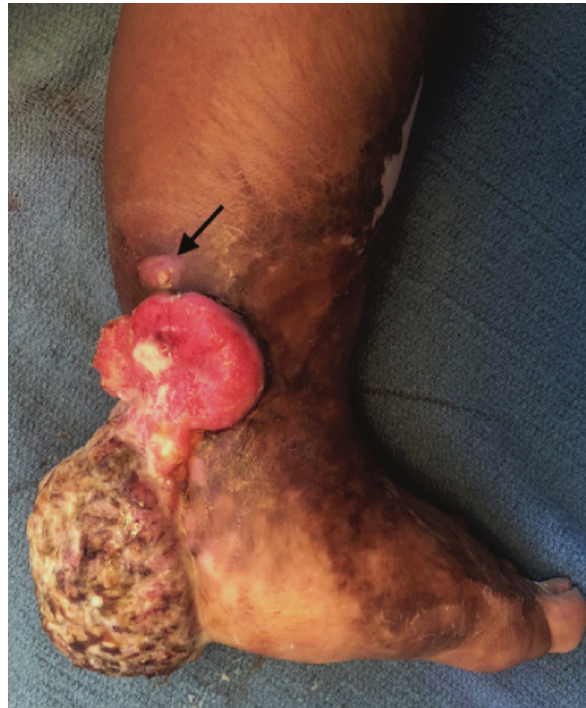
Lateral view of the foot. Involving the entire heel and Fig. 2: the insertion of the tendon of Achilles, the ulcerating mass is foul-smelling with beginning necrosis in some areas. Rapid growth is noticeable at its most proximal and medial margin. Scarring affects the entire foot, ankle, and distal leg. The forefoot is abducted and everted due to the contractures. Post-burn bent contracture deformities are evident on the 2nd-5th